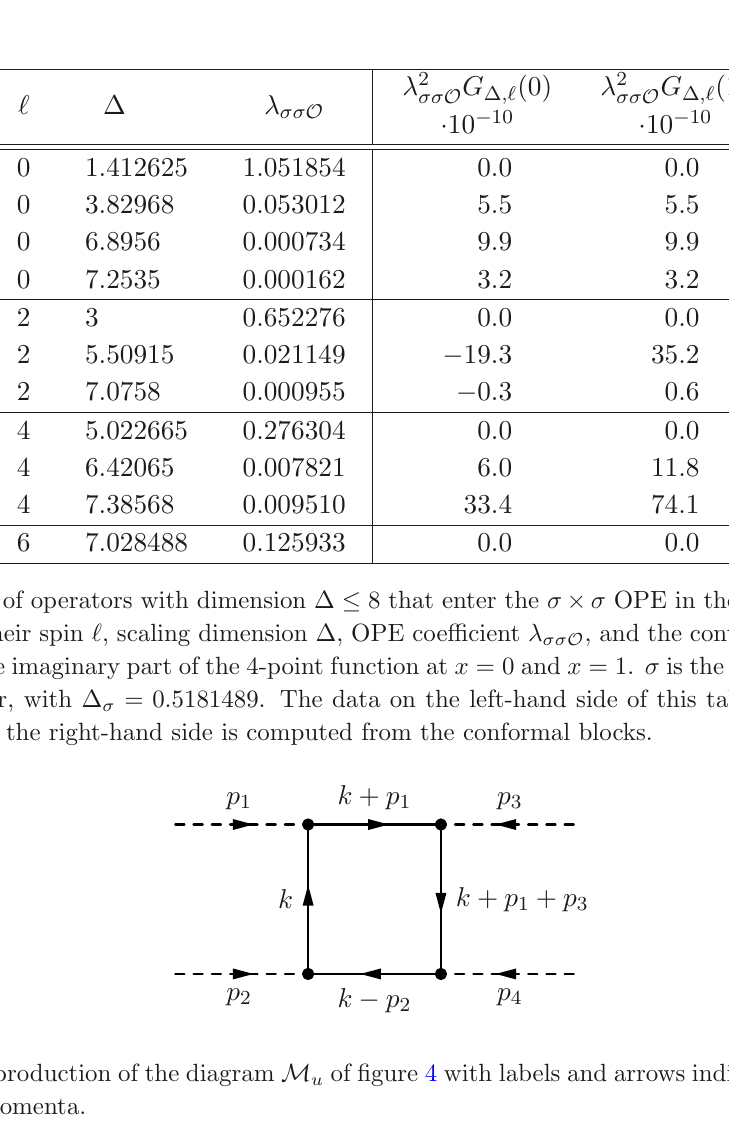
of figure 4 with labels and arrows indicating our choice M u